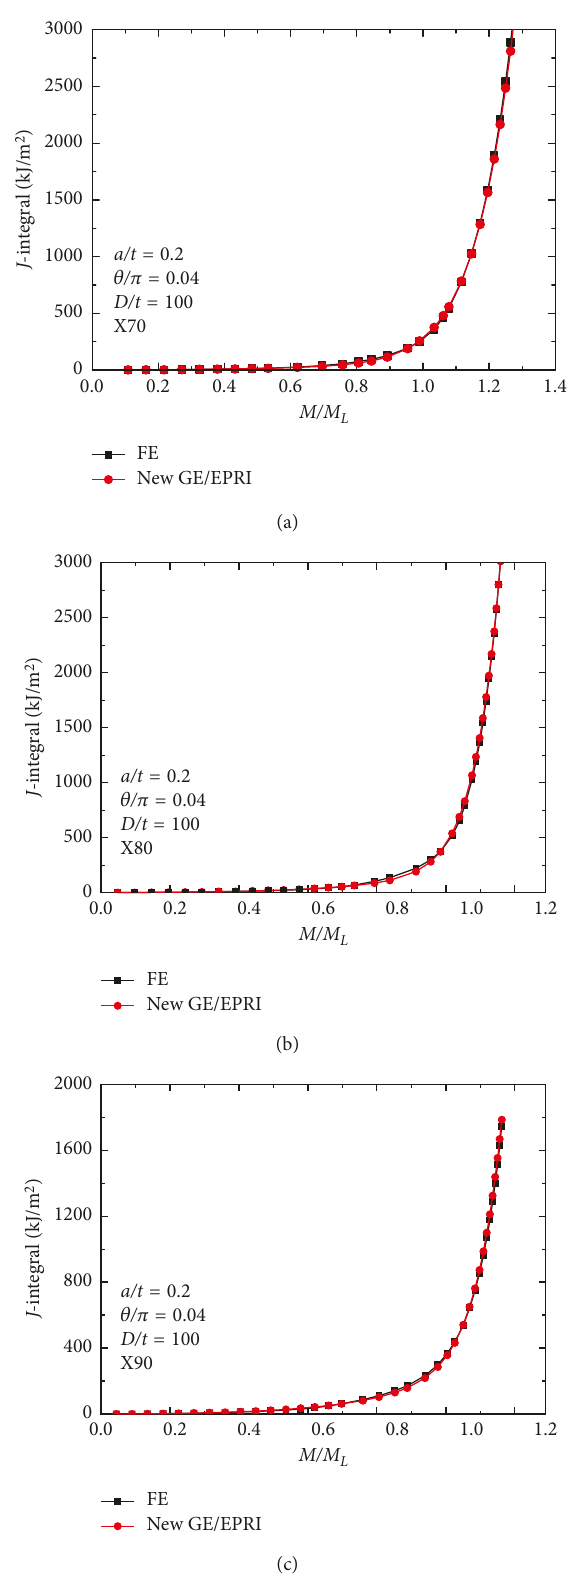
Figure 11: Comparison of J -integral estimated by using new elastic and plastic influence functions with FE results for thin-walled pipes under bending having D / t (b) X80; (c)